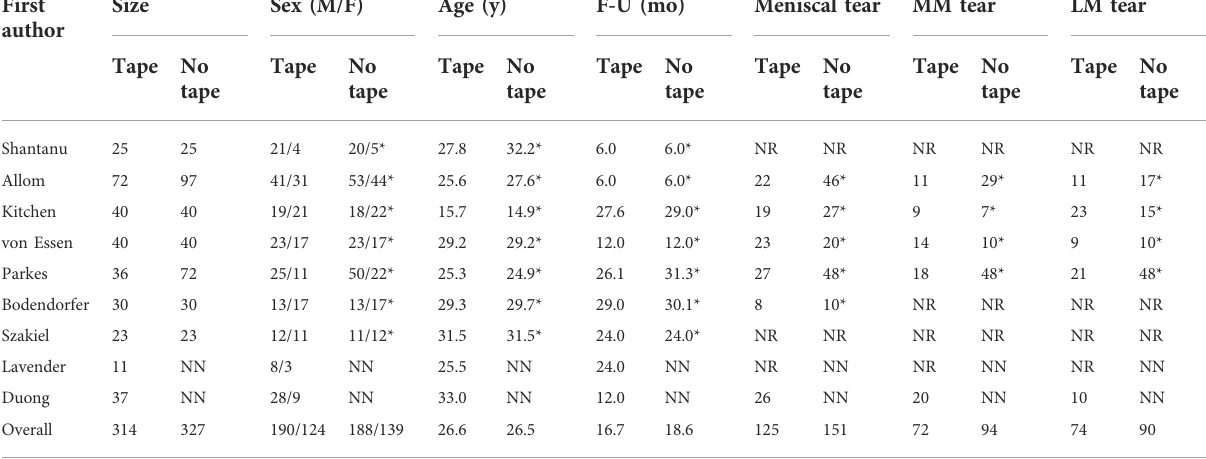
TABLE 3 Patient characteristics between anterior cruciate ligament reconstruction with or without suture tape